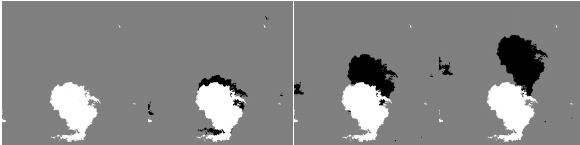
Figure 9: Cloud mask from previous image and simulated shadow masks for cloud heights (above ellipsoid) 1000, 1500, and 2000 m cloud height corresponding to this distance is h e c = 2019 ± 12 m above ellipsoid or h c = 1219 ± 15 m above ground. Using the satellite height H s = 631900 m − 800 m = 631100 m and speed v s = 7539 m/s together with a measured cloud border of ∆ s = 55 ± 10 m gives for the example cloud a